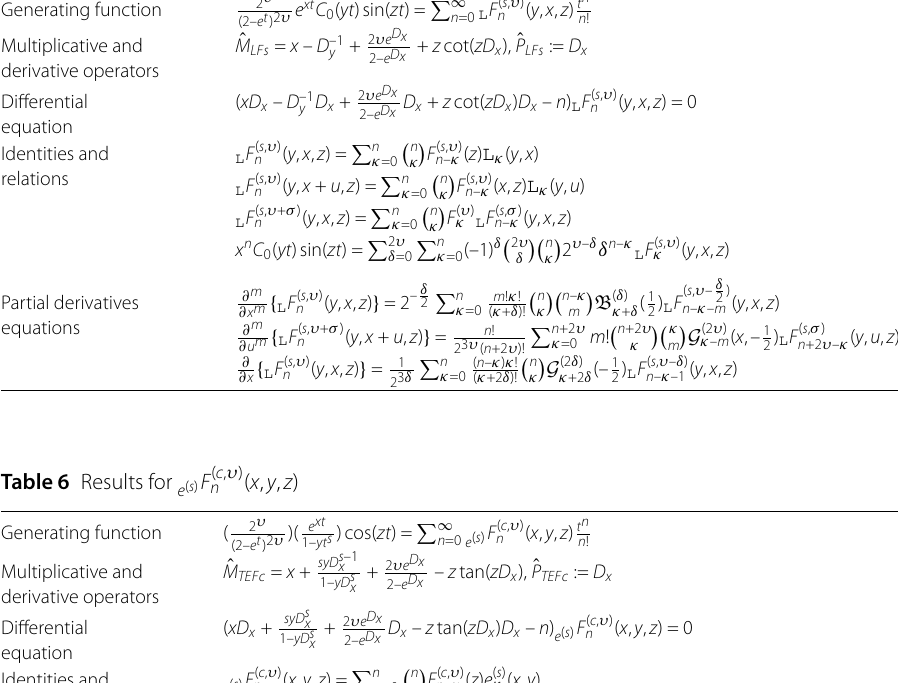
Table 5 Results for L F ( s , υ ) n ( y , x , z ) Generating function Multiplicative and derivative operators